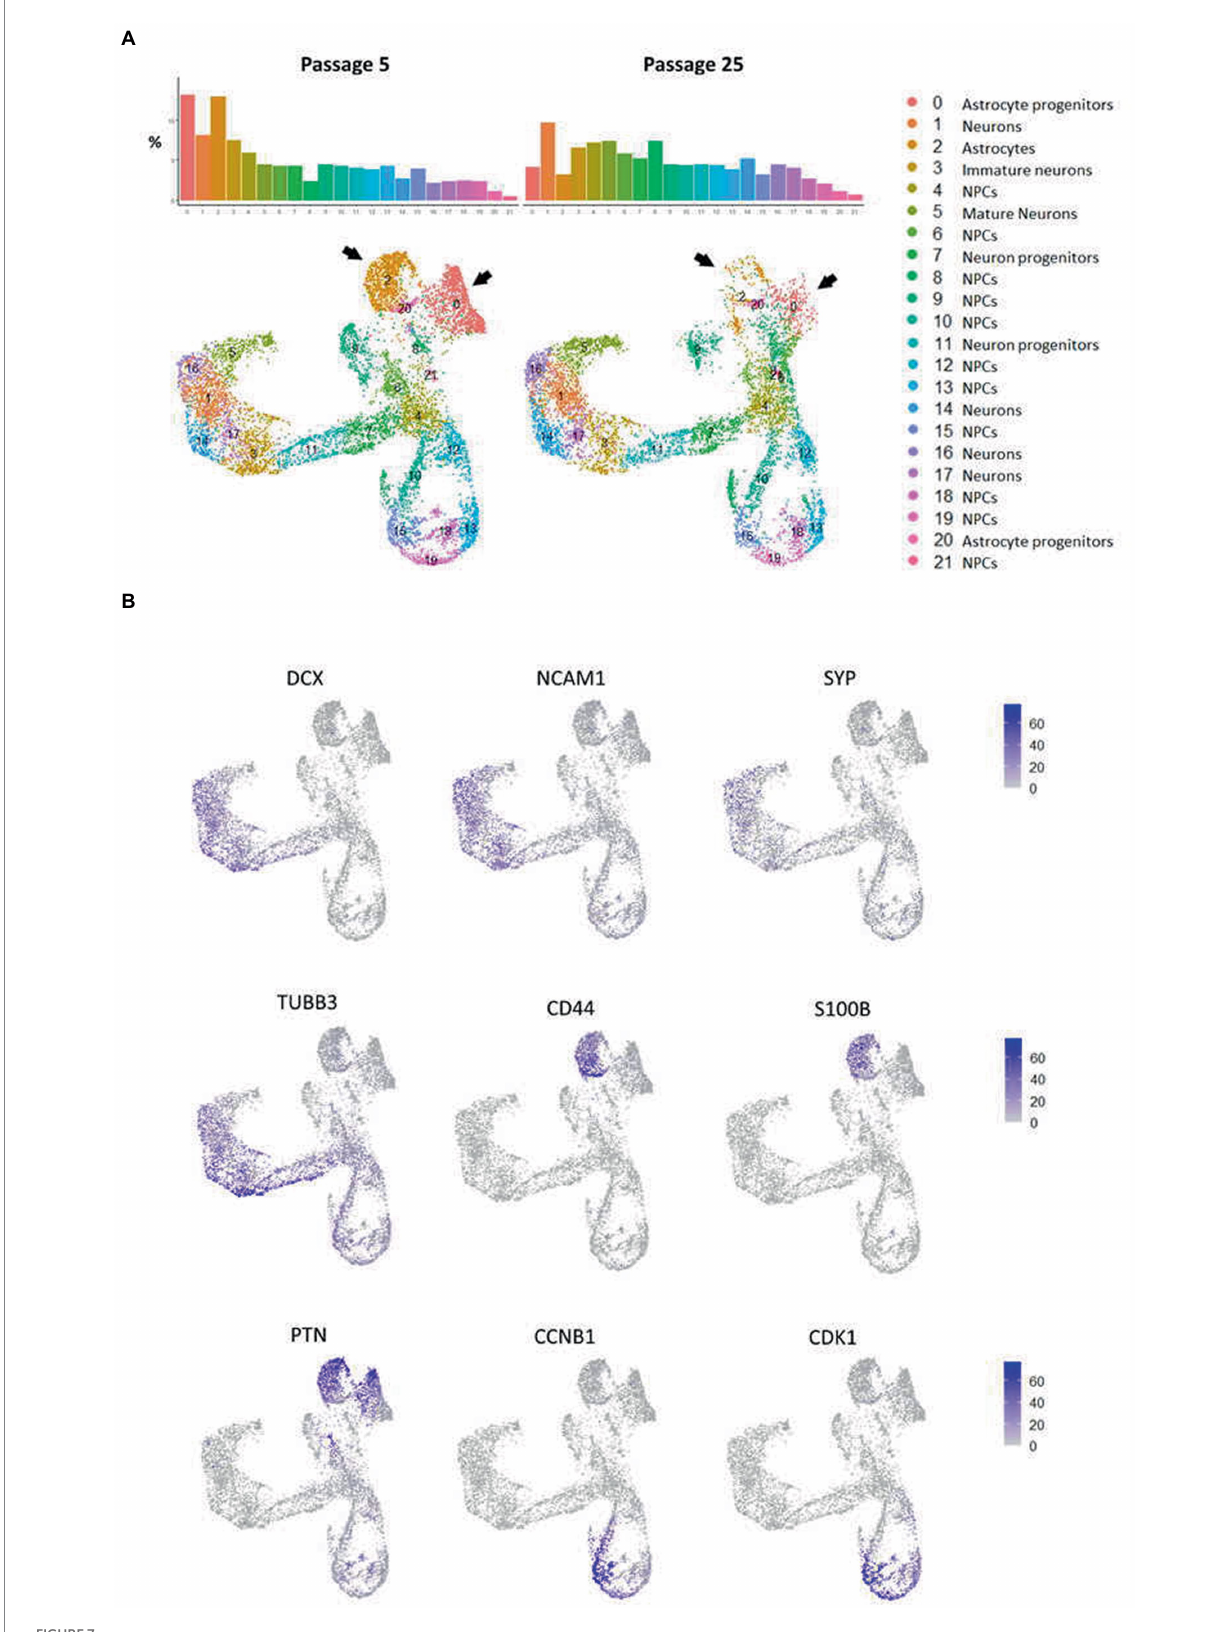
FIGURE 7 Cluster partition and annotation of scRNAseq data from N-KYOU p5 and p25. (A) 22 clusters revealed by the UMAP dimensional reduction of the scRNAseq algorithm in N-KYOU p5 and p25. The black arrows indicate the two clusters that differ most significantly in N-KYOU p25 compared to p5. (B) Gene activity of specific genes across the same UMAP space as on panel A. Markers of typical neural cell populations and cell cycle